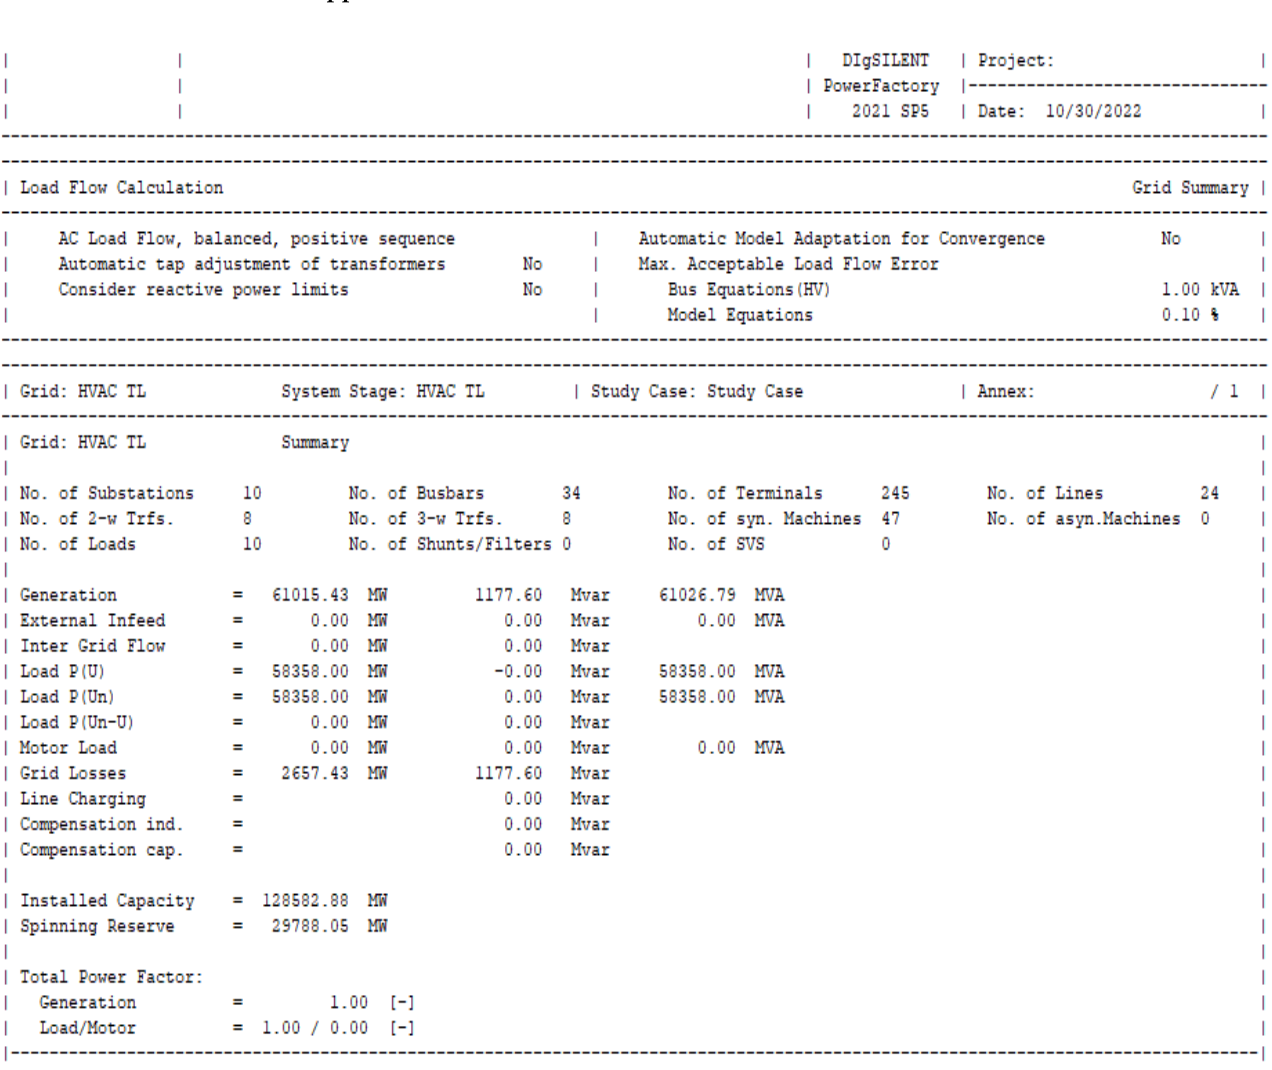
Figure A1. Southern African Regional Grid model base case summary for an HVAC load flow analysis, showing system losses and the total number of network equipment, including busbars, transformers, loads, and generators.